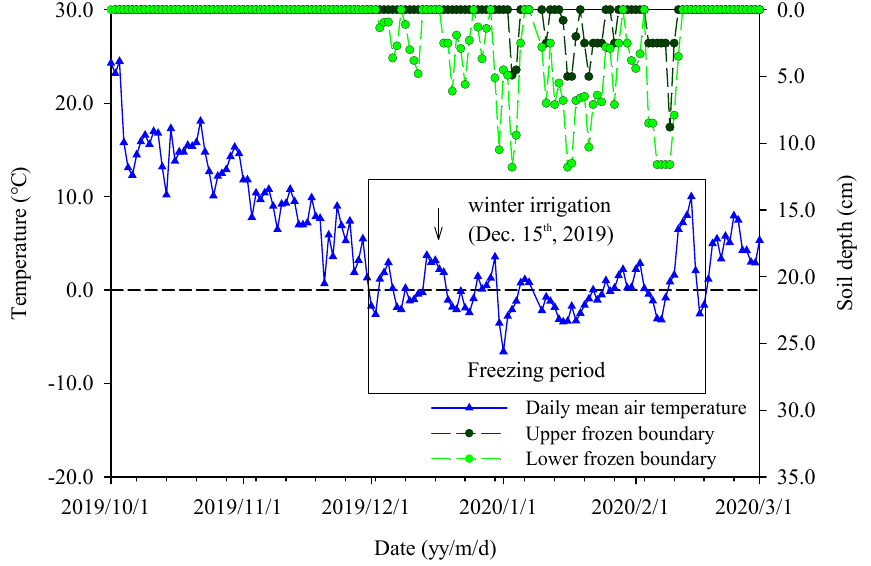
Figure 2. Dynamics of air temperature and soil frost depth in the field from 1 October 2019 to 1